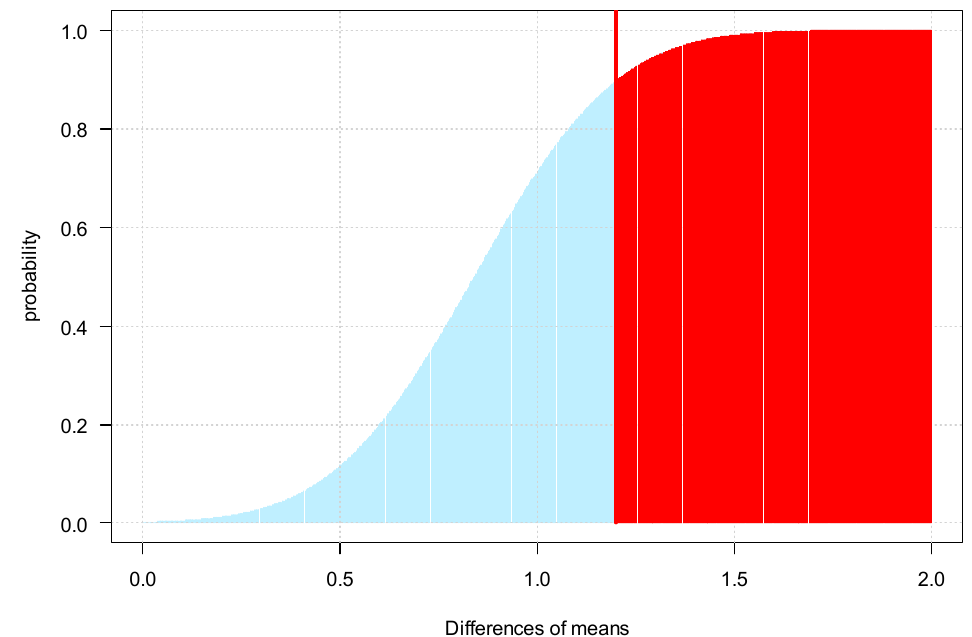
Figure 3. Distribution function of the “professional null hypothesis”, p = 0.9.